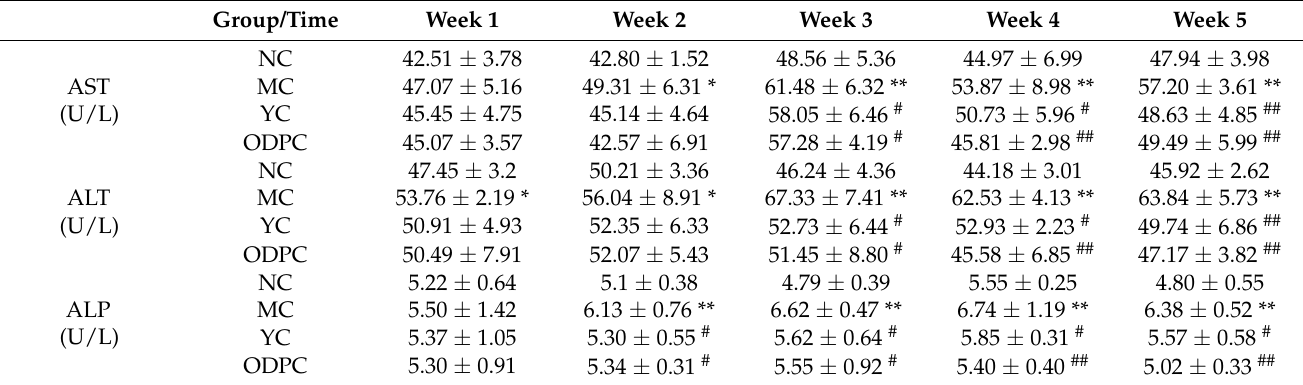
Table 2. Time–effect relationship of ODP on AST, ALT, and ALP in the liver of mice. Group/Time Week 1